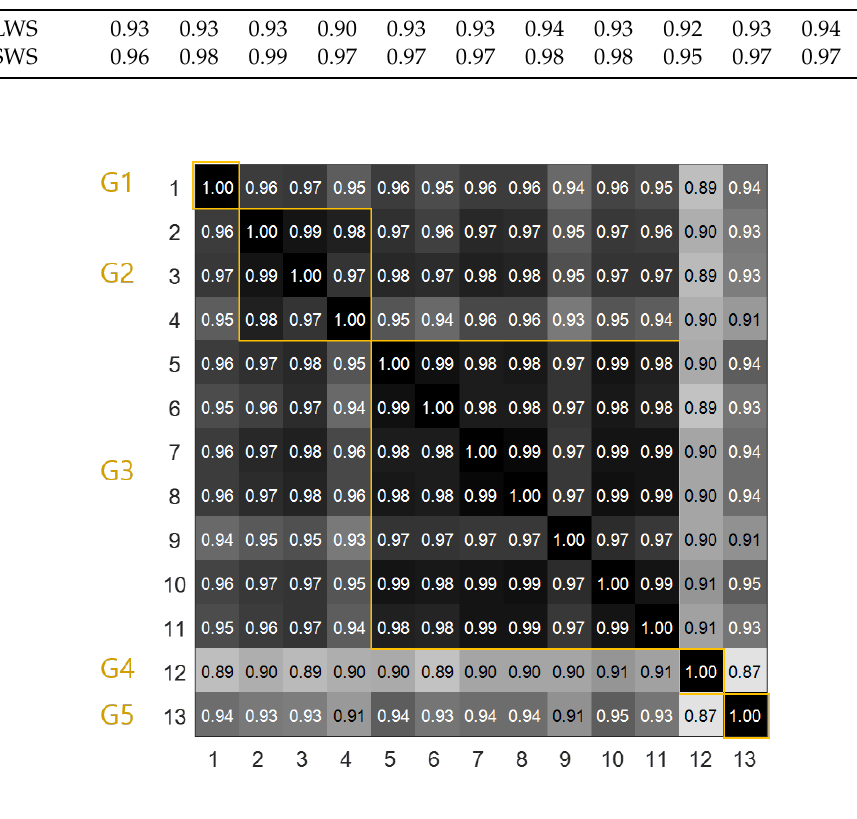
Figure 2. Cross-correlation of PV power output for the fleet.